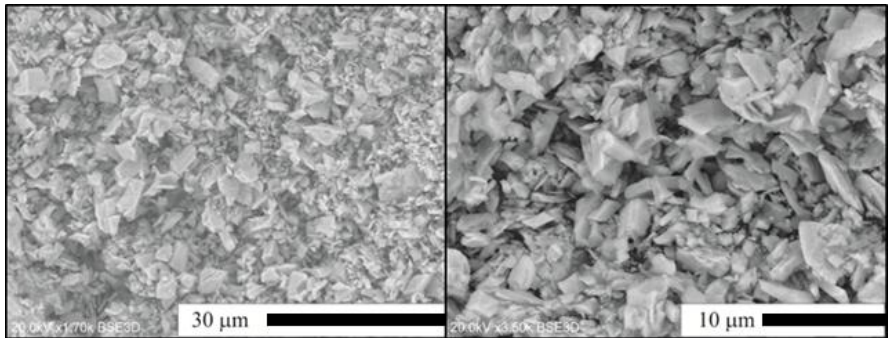
Figure 3. SEM images of the Lu 2 O 3 starting materials (Stanford Materials